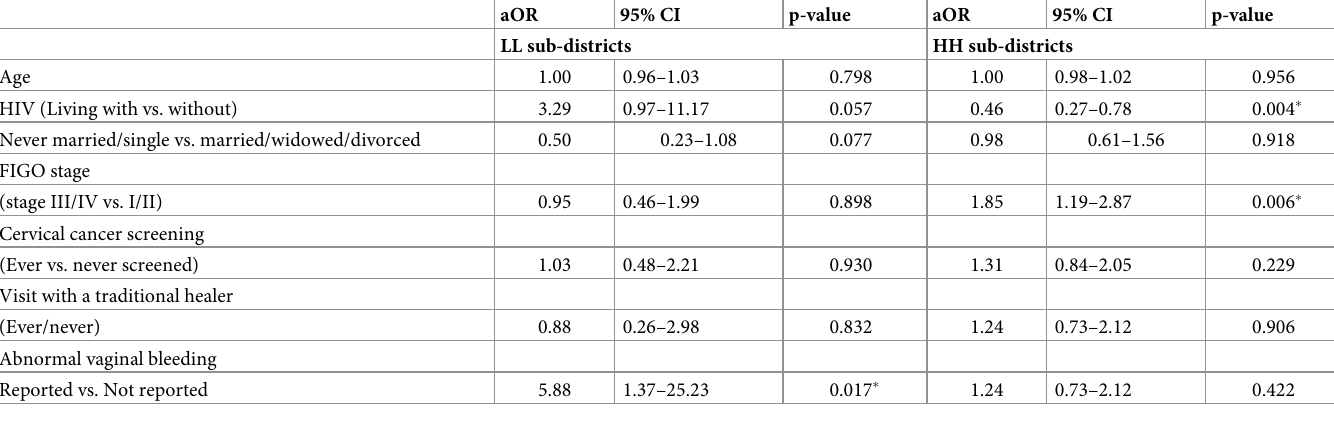
Table 6. Multivariable regression for individual level factors associated with patients presenting from identified HH and LL